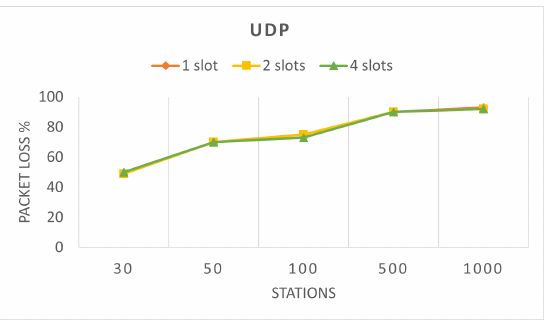
Figure 3. UDP network packet loss in 60 s for different number of stations and RAW slots without introducing selfish